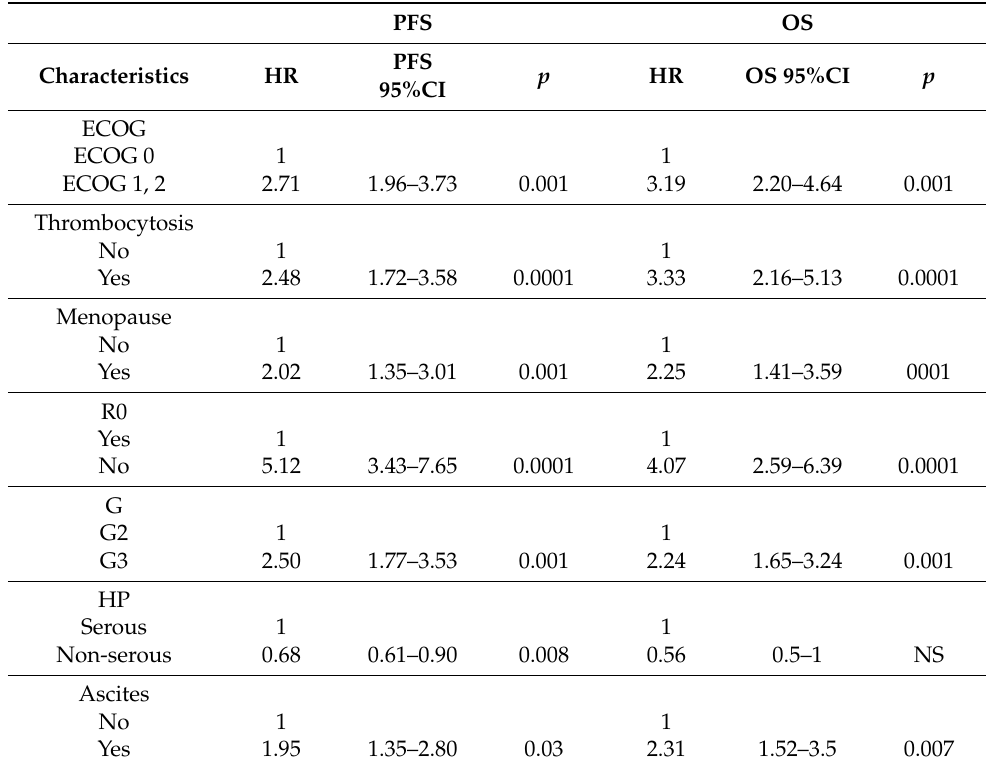
Table 2. Multivariate analysis of the prognostic factors for PFS and OS.